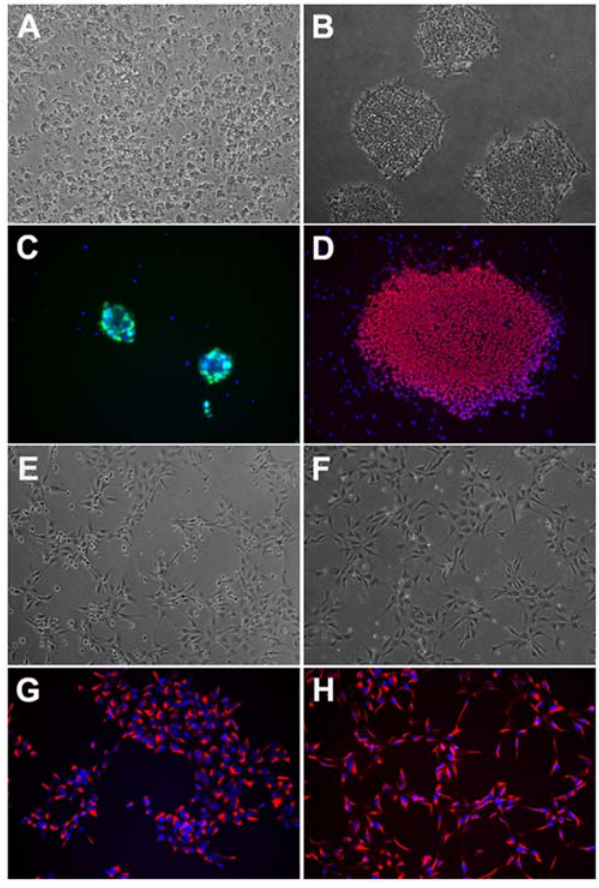
Figure 1. Morphology and expression of stem cell markers in hESCs and hESC-derived NSCs cultured in 96-well plates. (A–B) Typical undifferentiated hESC morphology 24 hours after plating (A) and 3 days after passaging (B). (C–D) Expression of pluripotent markers Oct4 in cells cultured in 96-well plates (C, Oct4=green, nuclei=blue) and colonies cultured in 60 mm dishes (D, Oct4=red, nuclei=blue). (E– F) Homogenous hESC-derived NSCs are morphologically similar whether cultured in 96 well plates (E) or larger 60 mm dishes (F). (G– H) Uniform expression of nestin in NSCs cultured in 96 well plates (G) and 60 mm dishes (H) Nestin=red,